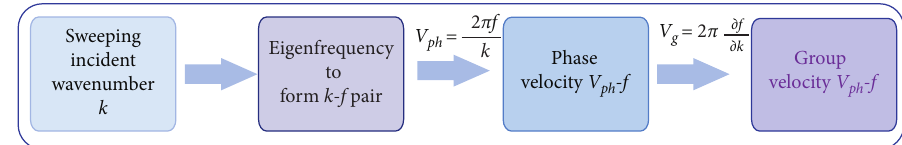
Figure 1: The process to calculate dispersion curves based on FB theory.